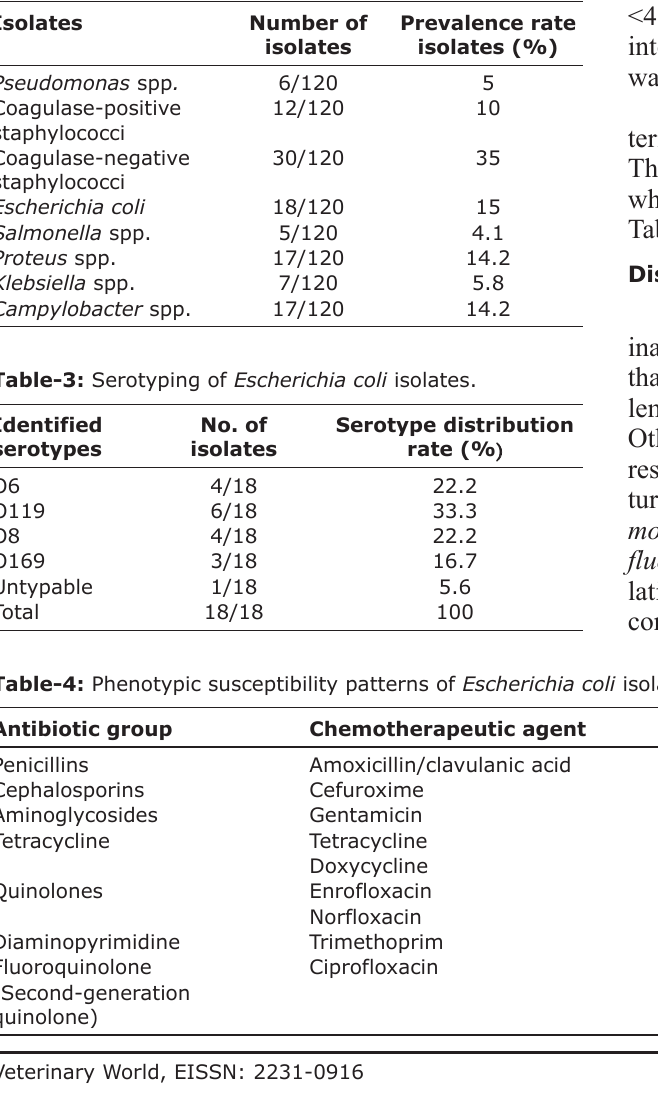
Table-2: Prevalence rate of isolates. Isolates Number of Pseudomonas spp .